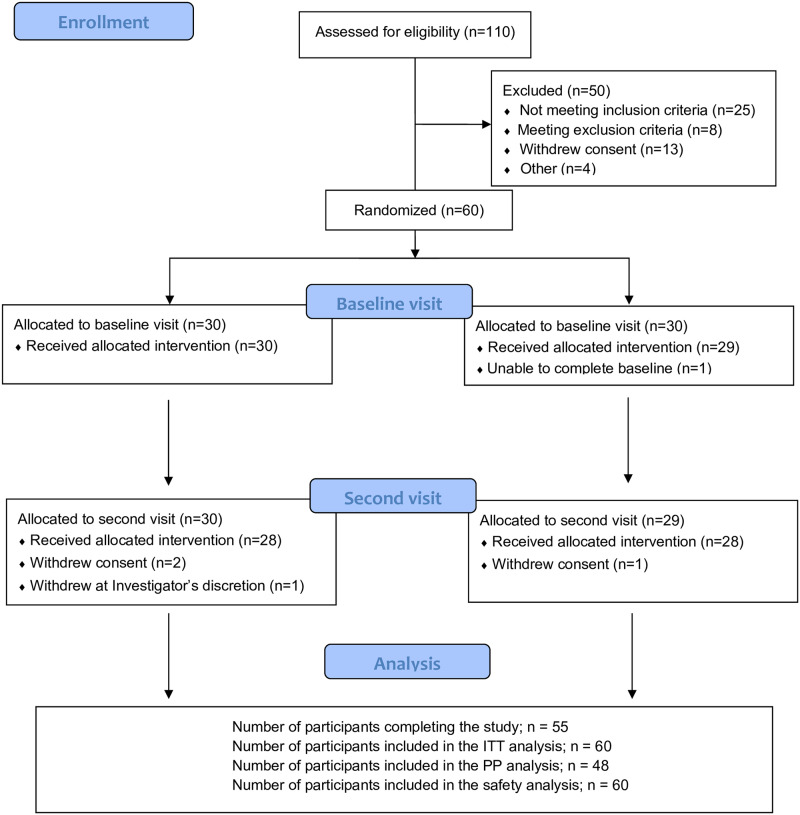
Participant flow.